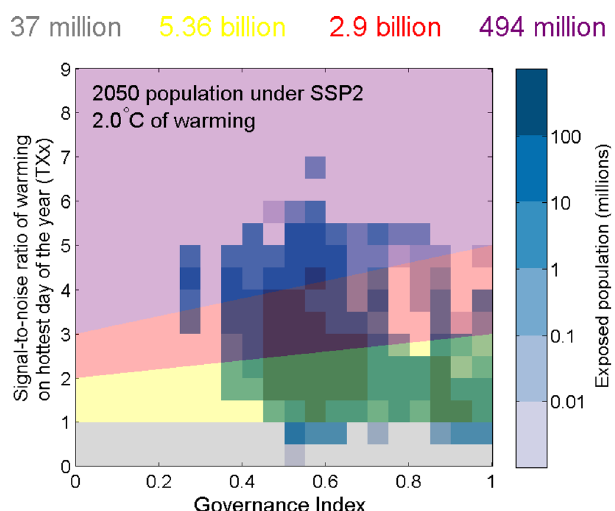
Fig. 2 Identifying the local exceedance of heat risk thresholds associated with the “ Reasons for Concern ” framework. Heat maps here show the range of country-level governance index ( x axis) and the signal-to-noise ratio of changes in the hottest day of the year (TXx, y axis) experienced by different fractions of the global population under one future scenario of warming and socioeconomic change. Population and governance index data are presented for the year 2050 under a middle-of-the-road socioeconomic scenario (SSP2) while the multimodel median exposure to extreme heat ( y axis) is shown in response to a global temperature rise of + 2 °C above early industrial levels. Coloured numbers above the panel denote the total number of people within each of the four risk designations, which are represented by shaded regions in the background of the main fi gure: purple represents “ very high ” risks; red represents “ high ” risks; yellow denotes “ moderate ” risks and grey denotes “ low ”